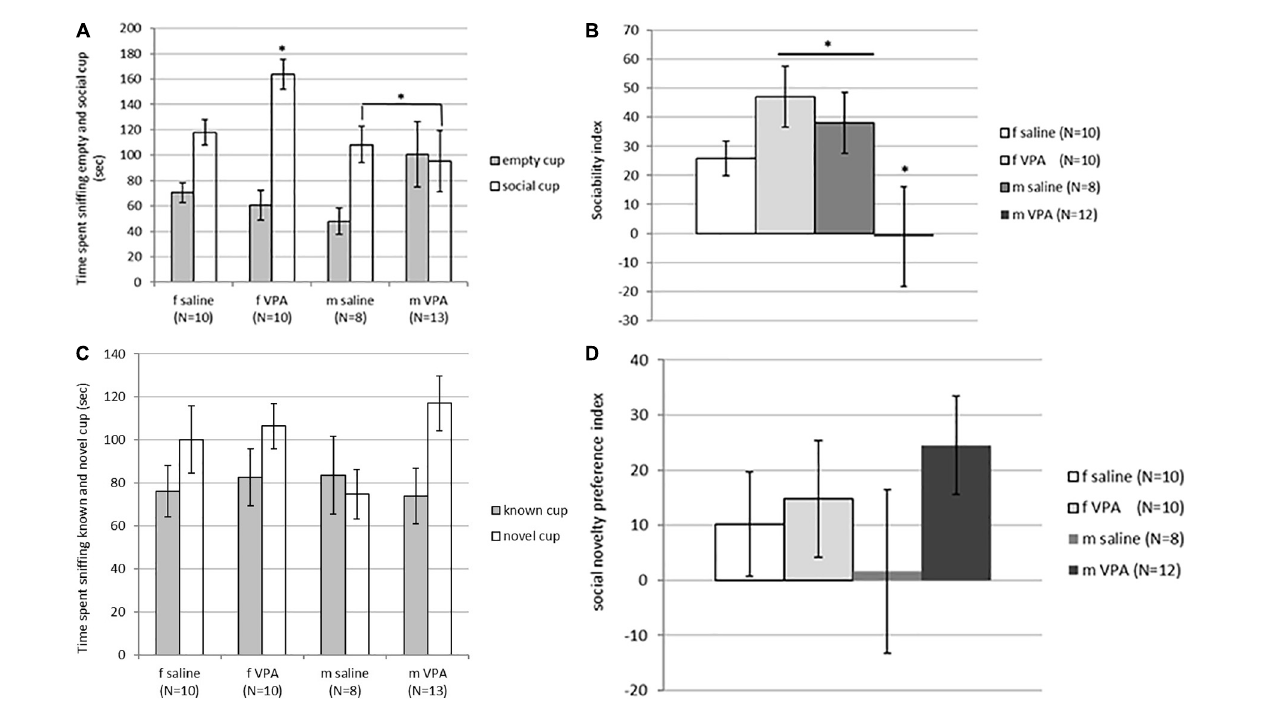
FIGURE3 (A) Behavior of control and valproate (VPA) mice in the second stage of the sociability test. Mice were introduced with an empty (non-social) cup and a cup containing stimulus male (social). VPA females spent significantly more time sniffing the social cup than VPA males and control males ( p ∗ < 0.05). (B) Behavior of control and VPA mice in the second stage of the sociability test. Mice were introduced with an empty (non-social) cup and a cup containing stimulus male (social) cup. The sociability index was significantly lower in VPA males compared to saline males and VPA females ( p ∗ < 0.05). (C) Behavior of control and VPA mice in the third stage of the sociability test, in which the mice were introduced with a familiar (known cup) and novel stimulus animals (novel cup). No differences were observed between groups in time spent sniffing different cups. (D) Behavior of control and VPA mice in the third stage of the sociability test, in which the mice were introduced with a familiar (known cup) and novel stimulus animals (novel cup). No differences were observed between groups in the social novelty preference